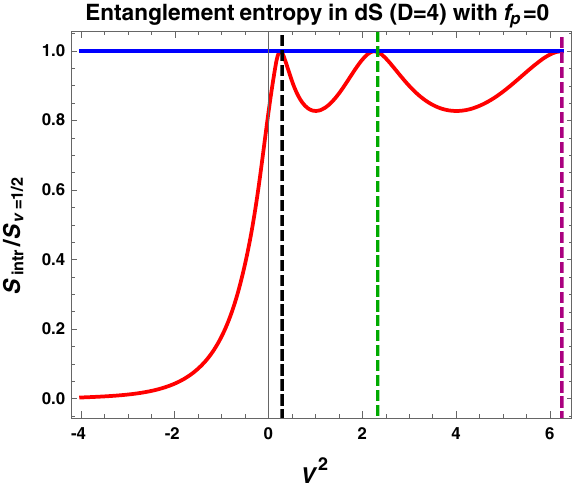
( a ) Normalized entanglement entropy vs ν 2 in 3 + 1 D de Sitter space without axionic source ( f p = 0). Fig. 7 Normalisedentanglemententropy S intr / S ν = 1 / 2 vs.massparam- eter ν 2 in 3 + 1 D de Sitter space in the absence of the axionic source ( f p = 0) and in the presence of the axionic source ( f p = 10 − 7 ) for